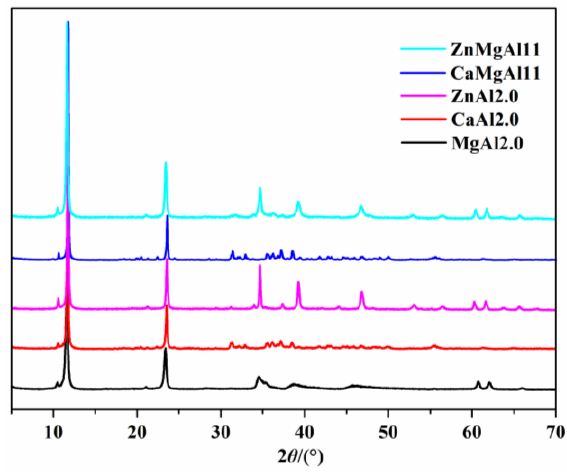
Figure 2. The XRD patterns of LDHs with various metal elements in the layers.